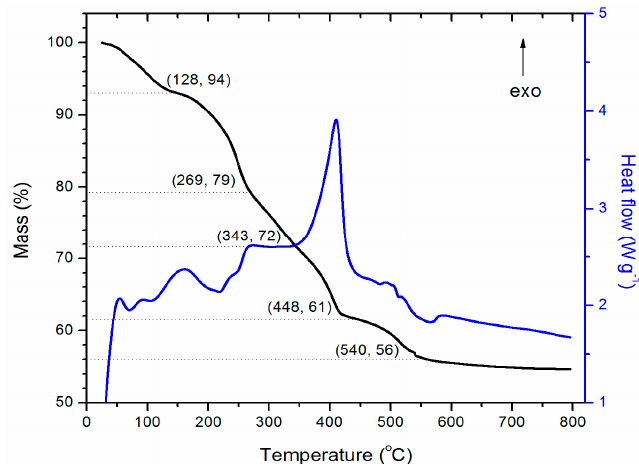
Figure 3. X ‐ ray diffraction (XRD) patterns of the pristine LDH and the LDH ‐ gallate product obtained in isopropanol under nitrogen atmosphere.